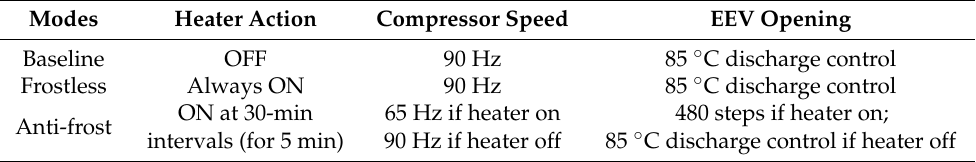
Table 2. Co-actions of system components in the three modes during heating